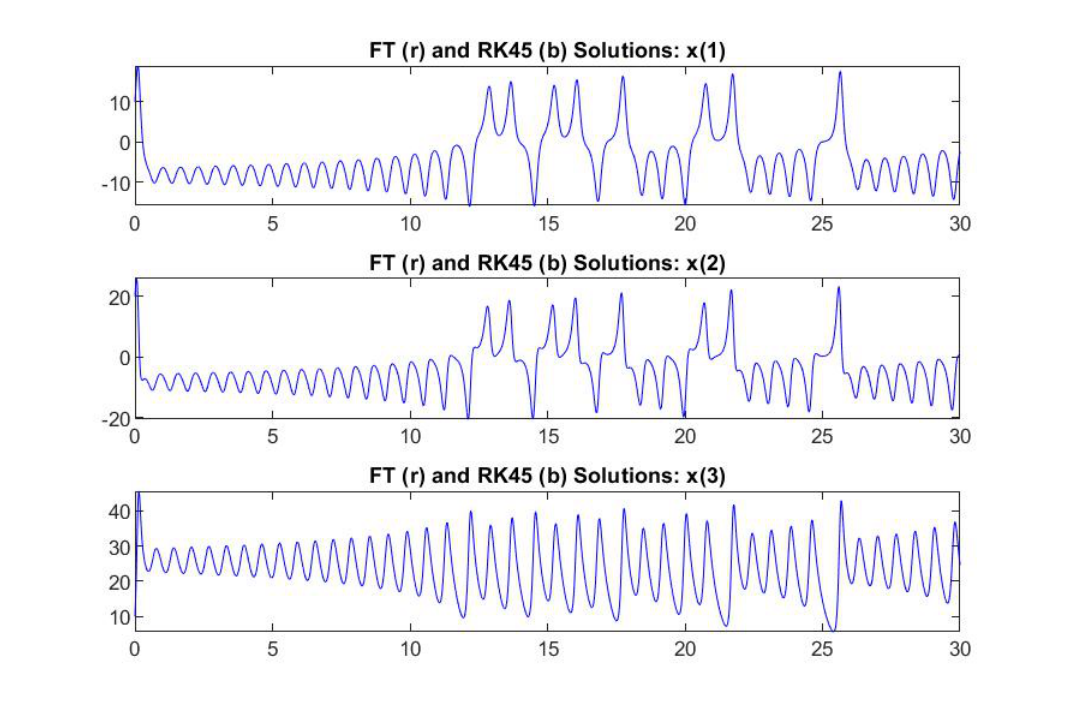
Figure 5. Problem No4 (Lorenz system): The three components x j ( t ) , j = 1,2,3 are displayed in the order from top to bottom; FT solution is red-colored, RK solution is blue-colored. Remark that this system, with the given values of parameters, exhibits a strong sensitivity to changes in initial conditions and the numerical solutions are a famous example of chaotic trajectory.